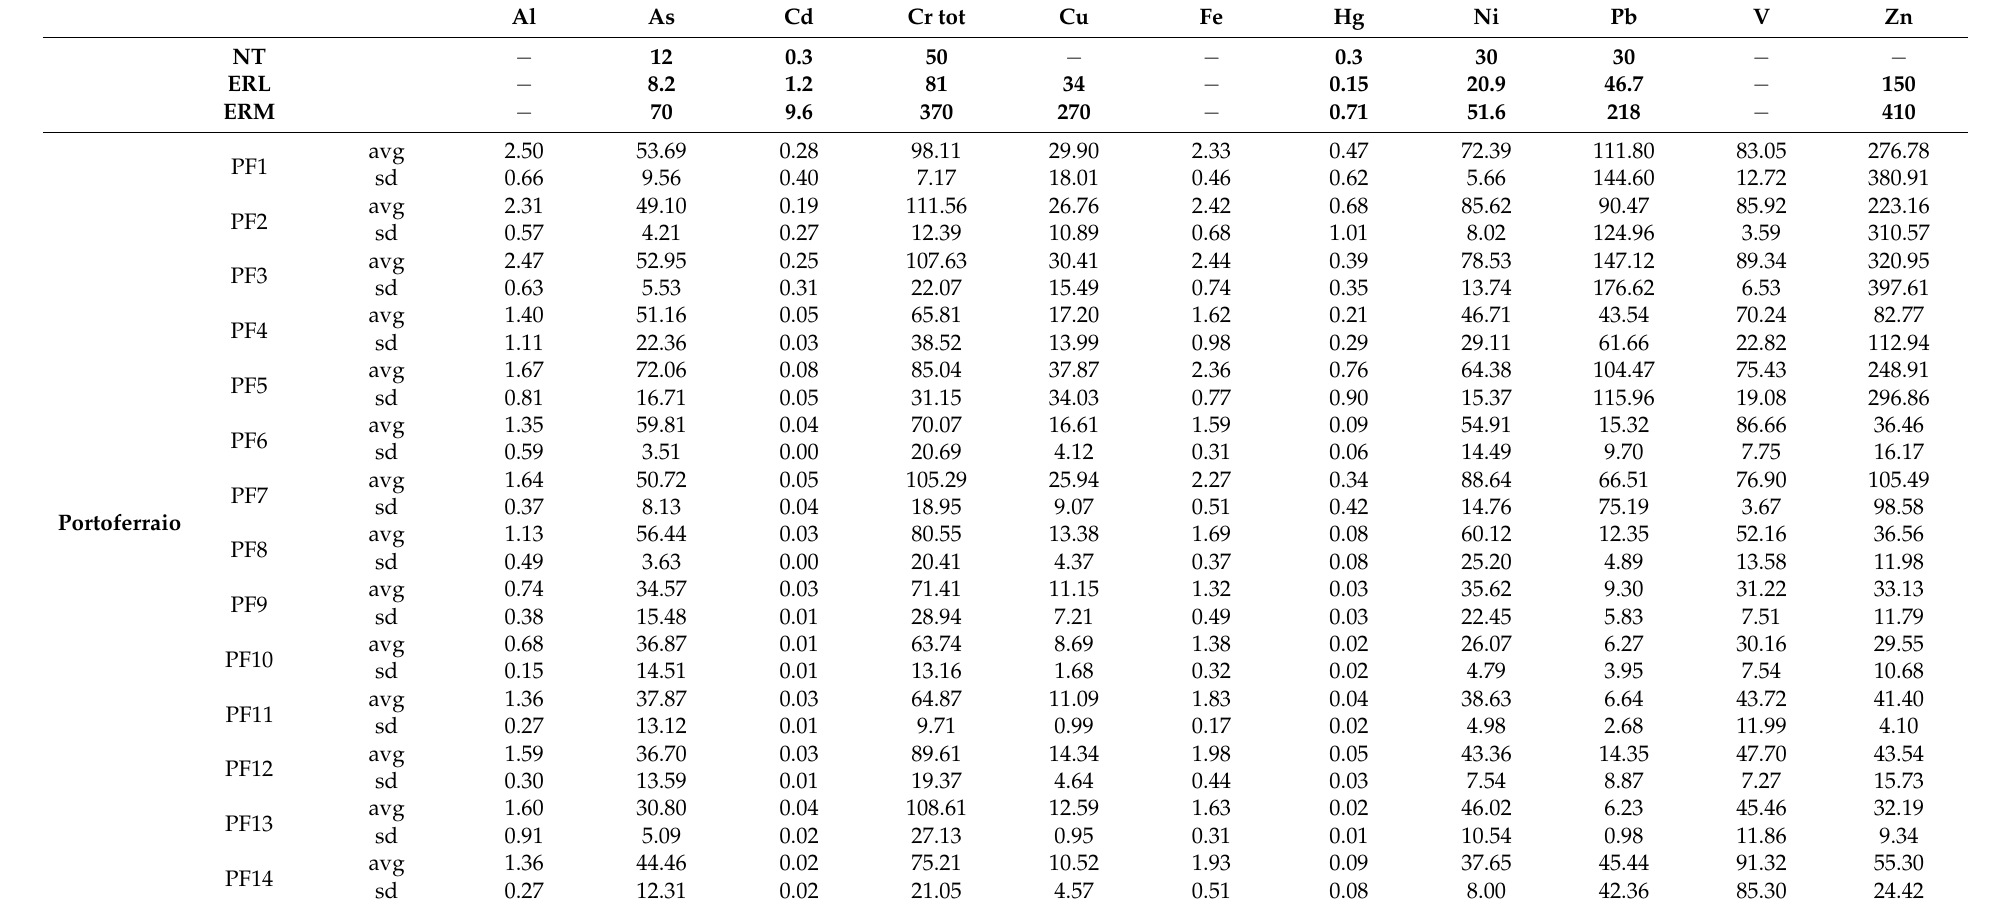
Table A3. Trace Metals Concentration (Average and Standard Deviation). Units: mg/kg d.w. (Al and Fe: % d.w.).National Thresholds (NT, According to DL56/2009), ERL and ERM (according to Long et al., 1995) are also